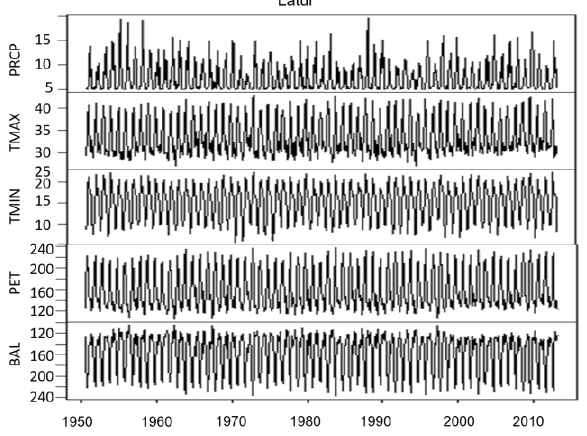
Figure 3. Distribution of Precipitation, TMAX, TMIN, PET, and Climate water balance data over Latur district.